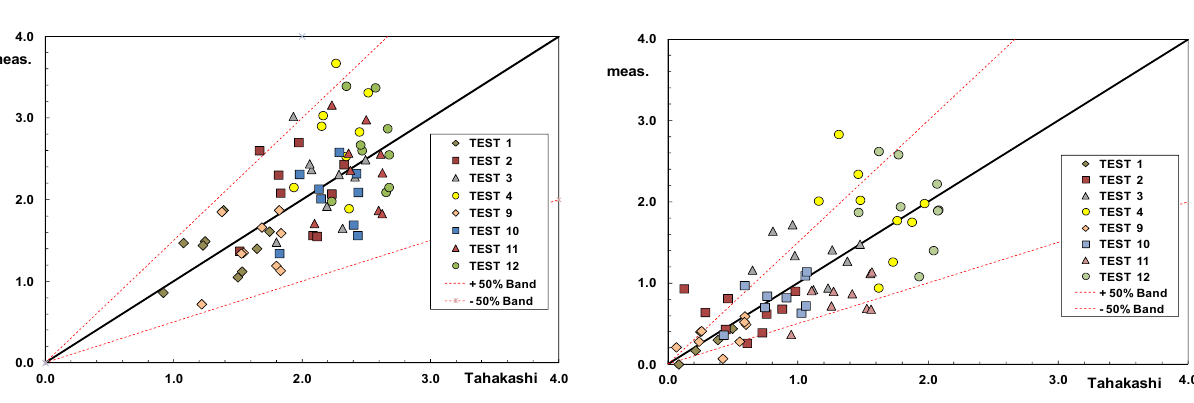
Figure 12. Effect of Takahashi et al. correction [Equation (10)]. Left panel: Front waves; low panel: right waves. Data in kN/m 2 .